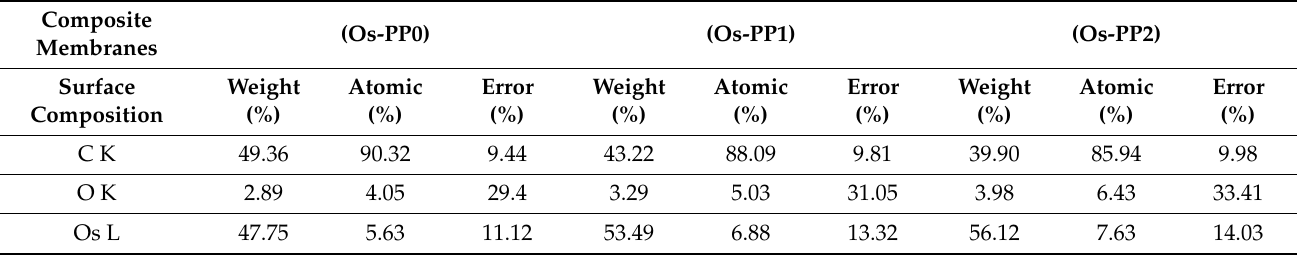
Table 1. Energy dispersive spectroscopy analysis (EDAX) for the osmium-polymer membranes.